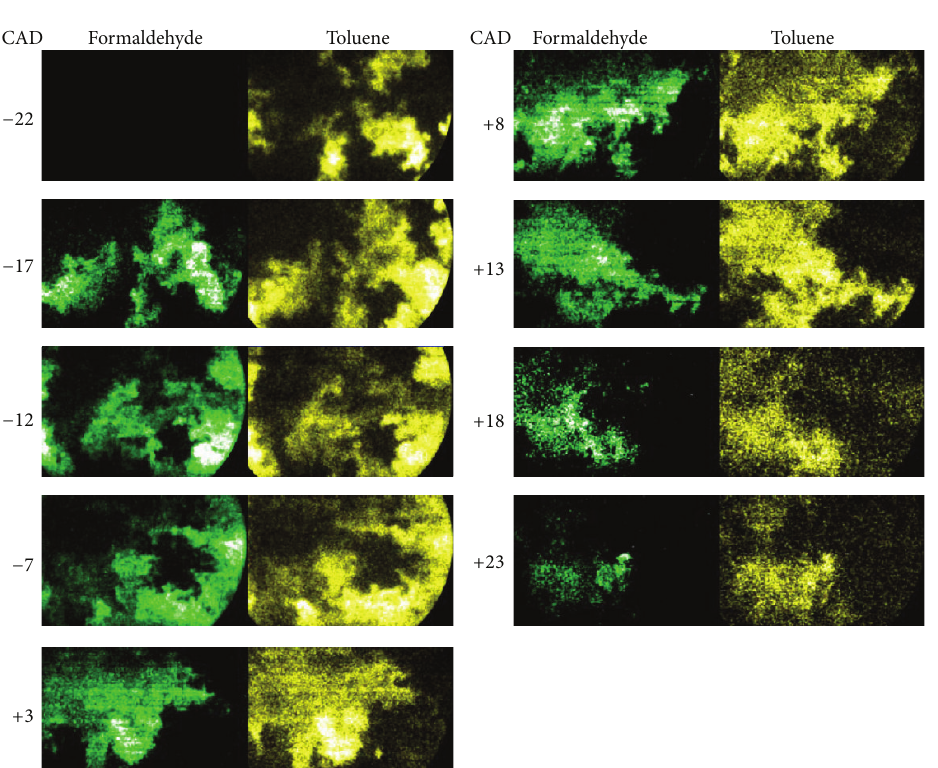
Figure18:Simultaneousimagesofformaldehydeandtolueneatstartofinjectionof − 35 ∘ CAATDCtoformastratifiedmixturebeforeignition